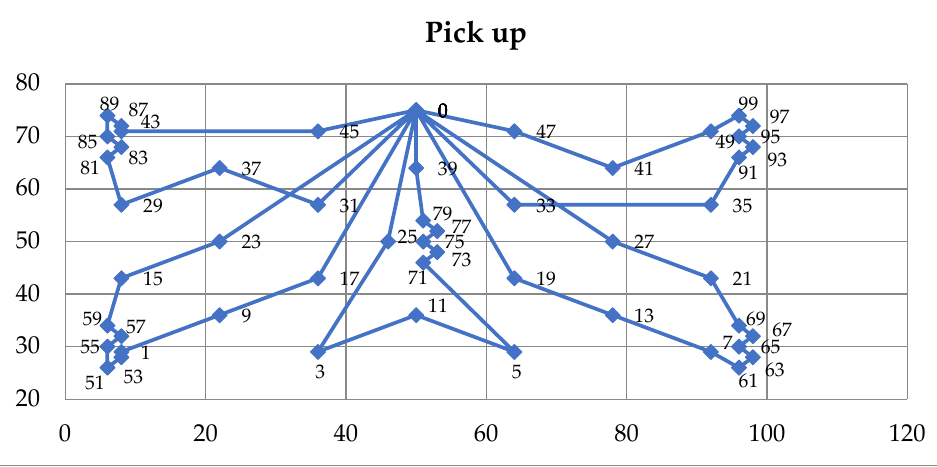
Figure A1. Optimized pickup routes from sAIS for instance 53P1.